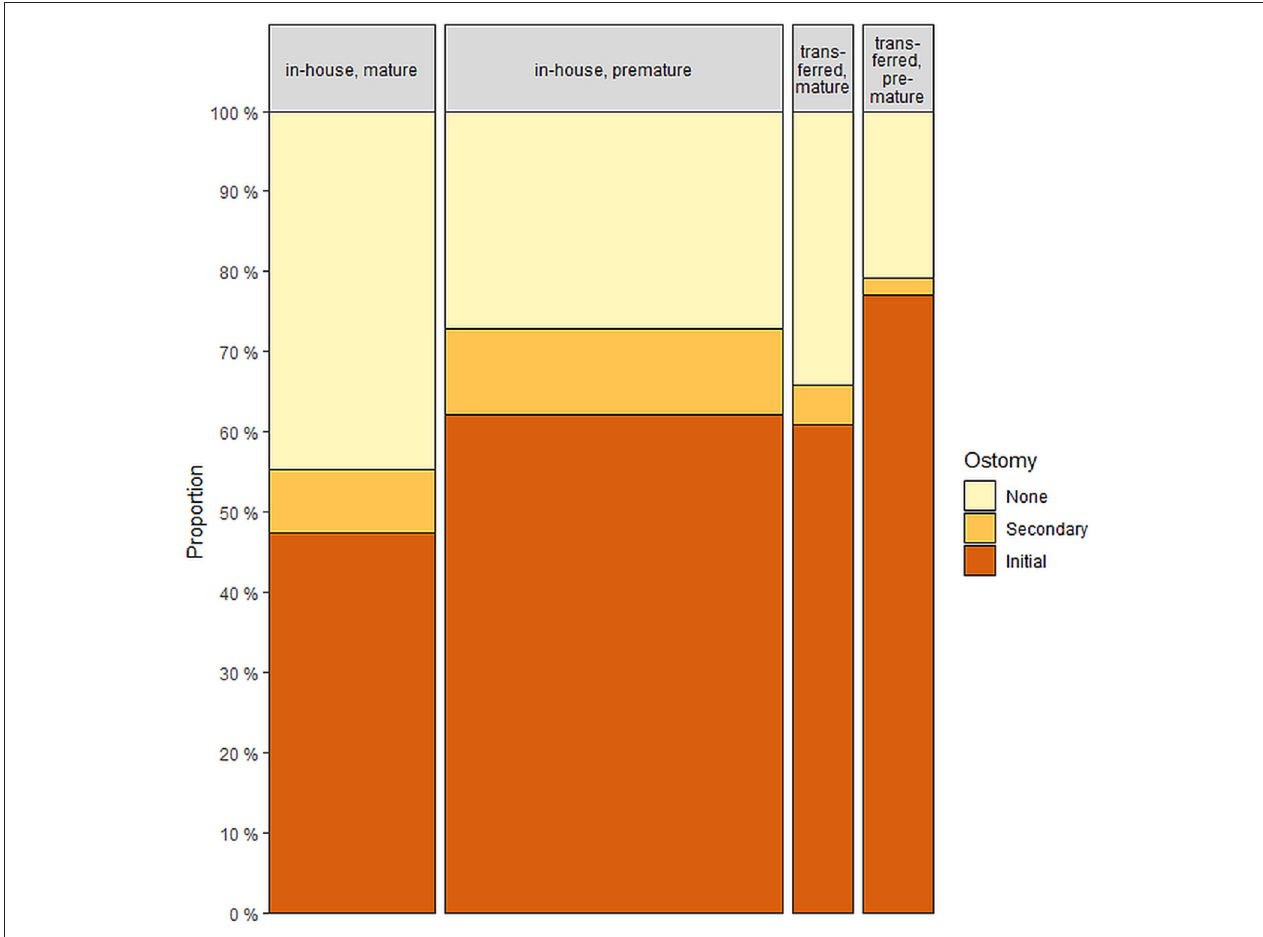
FIGURE 3 | Distribution of patients regarding ostomy with ( n = 89) and without ( n = 346) transfer prior to first surgical